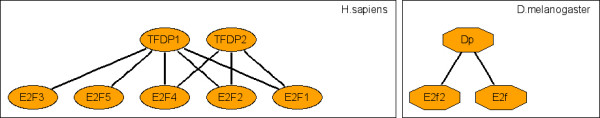
Representative c-CoNS: E2F/DP transcription factor complex.